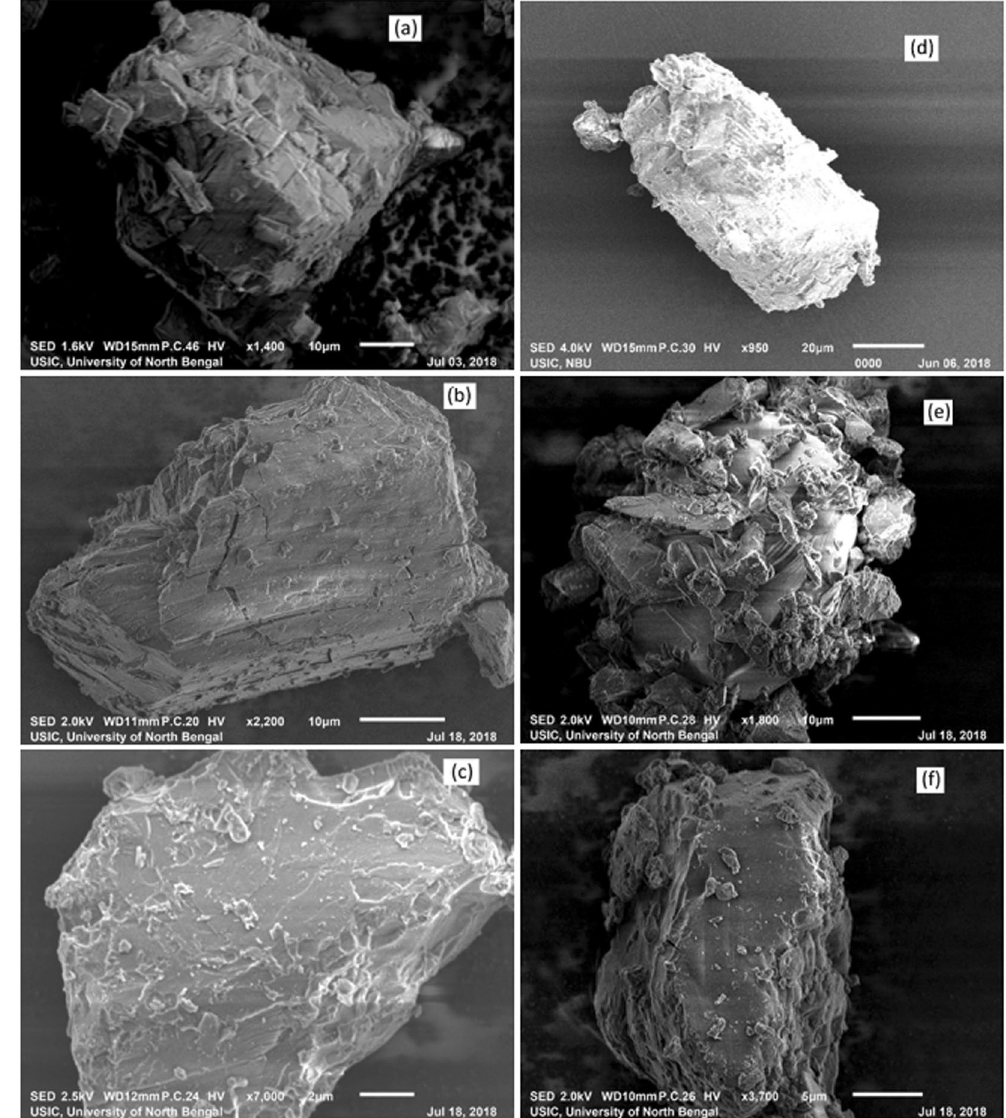
Figure 18. (a , b , c , d , e , f) SEM images of (a) α -CD, (b) (PEH + α -CD) physical mixture, (c) (PEH + α -CD) inclusion complex (d) β -CD, (e) (PEH + β -CD) physical mixture, (f) (PEH + β -CD) inclusion